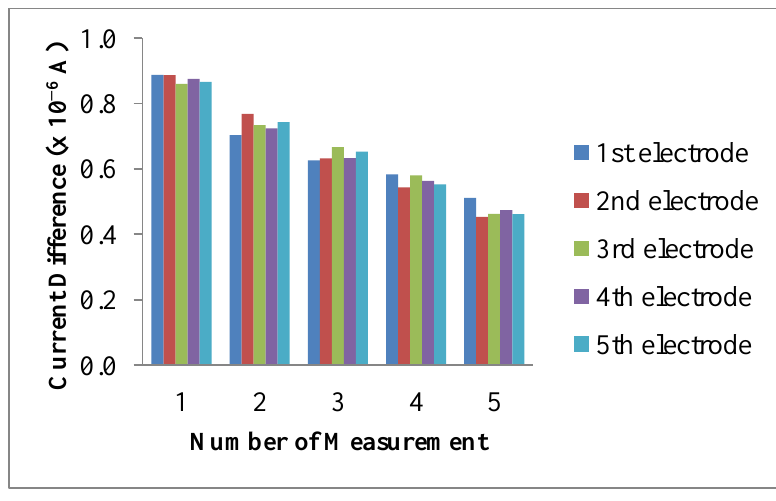
Figure 12. The reproducibility and repeatability of the reagentless NH 4+ ion biosensor that has been exposed to 30 mM NH 4+ ion at pH 7 (n =